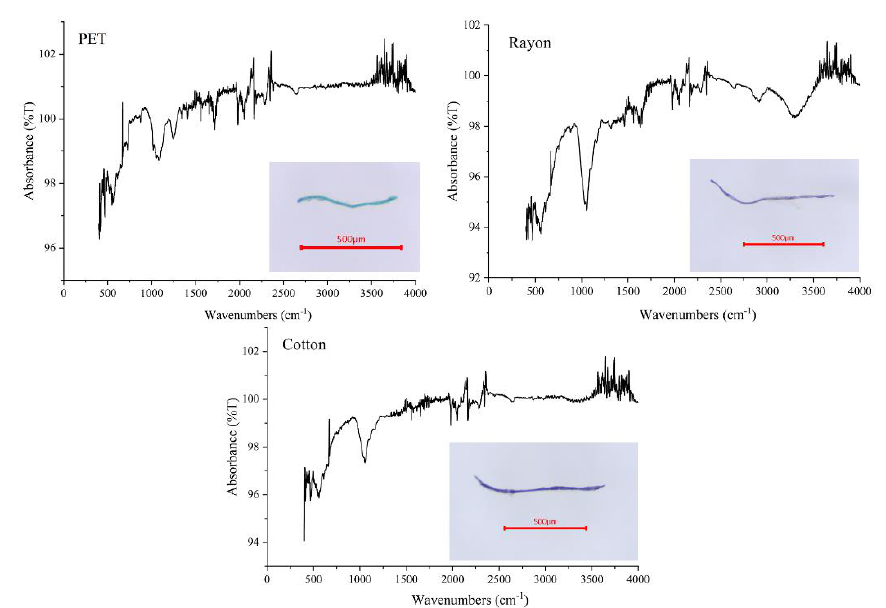
Figure 9 . Three types of polymers were found in fish eggs : PET, rayon, and cotton . Figure 9. Three types of polymers were found in fish eggs: PET, rayon, and